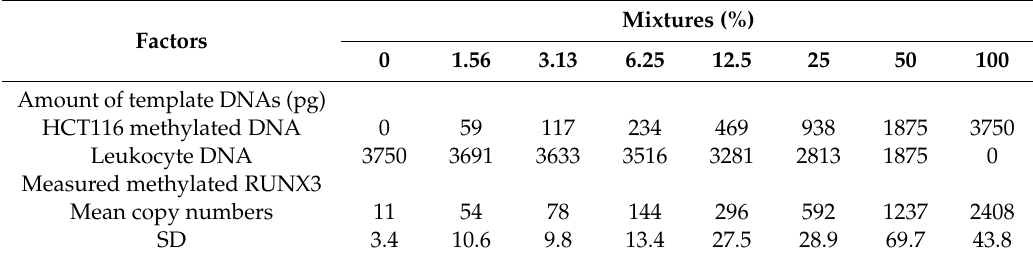
Figure 1. Basic test of combined restriction digital PCR (CORD) assay performance. The x axis represents the ratio of methylated HCT116 DNA to leukocyte DNA in the template DNA. The y axis represents methylated copy numbers for RUNX3, as determined experimentally. Table 1. Summary of basic test of CORD assay performance.